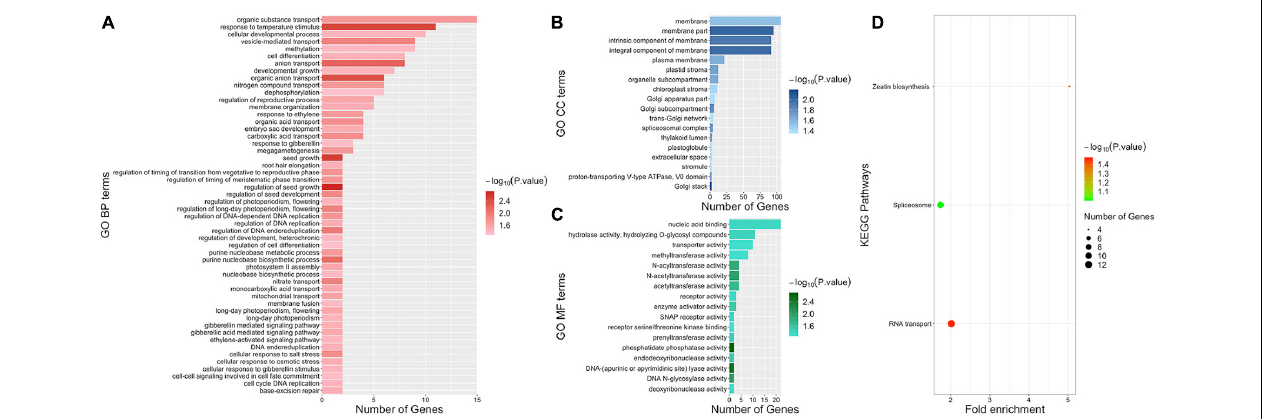
FIGURE 6 | Functional enrichment results of all candidate genes. Panels (A–C) represent GO BP, GO CC, and GO MF terms, respectively. GO terms are shown on the left. Different colors indicate the significance of GO terms. The length of each bar represents the gene numbers enriched in each term. Panel (D) illustrates KEGG pathways. Pathways are shown on the left. Different colors indicate the significance of pathways. The size of the dot represents the number of genes enriched in each